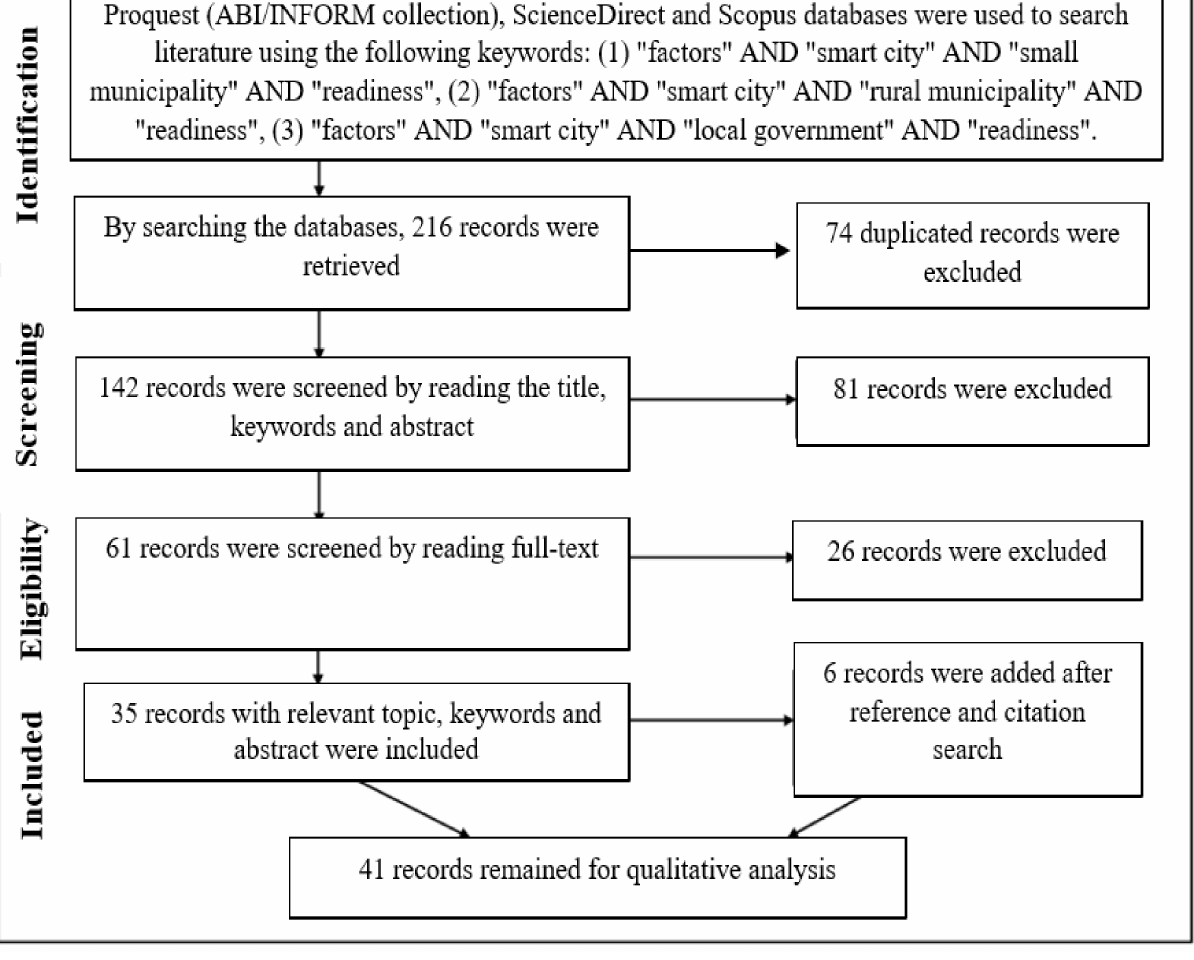
Figure 1. Literature identification